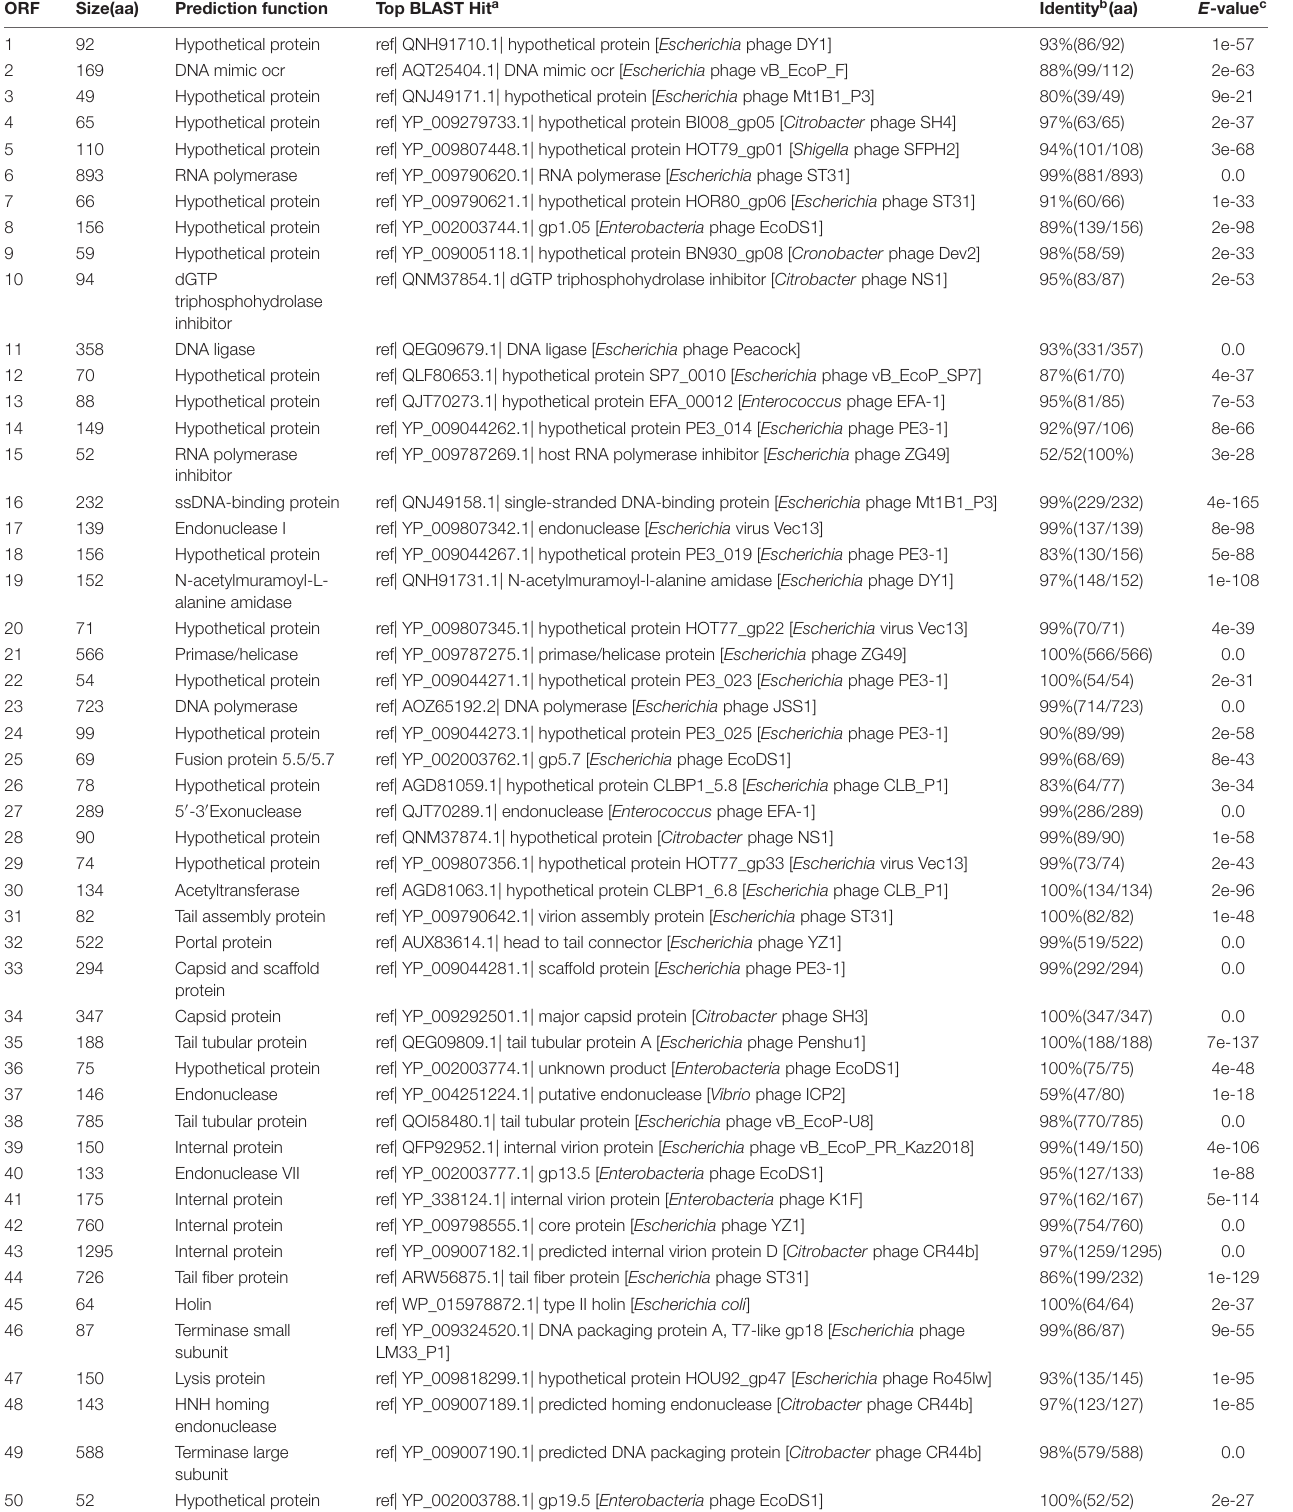
TABLE 2 | Open reading frame (ORF) analysis of the Hafnia phage Ca